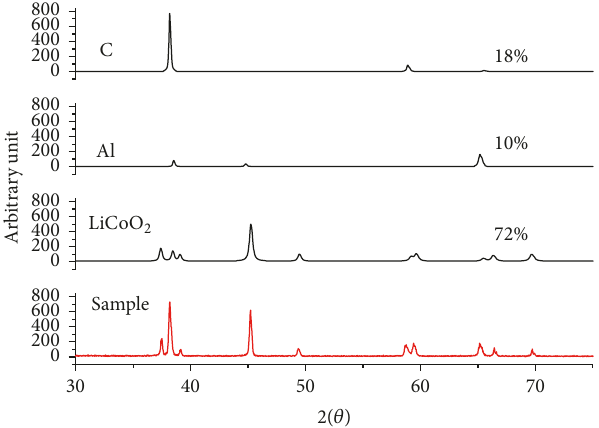
Figure 3: The X-ray diffractogram of LIB spent cathode tape before MB discoloration reaction. The proportion of phase was analyzed with Rietveld method using the free software FullProf©.